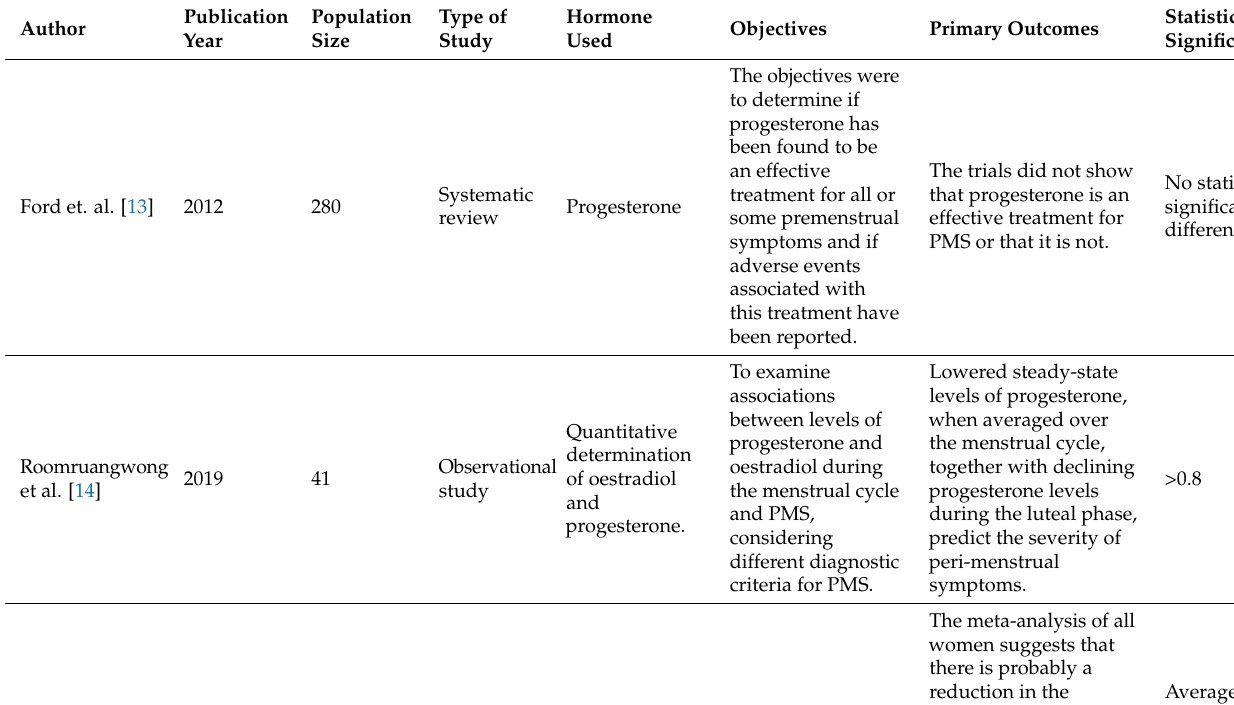
Table 1. Characteristics of the most important included